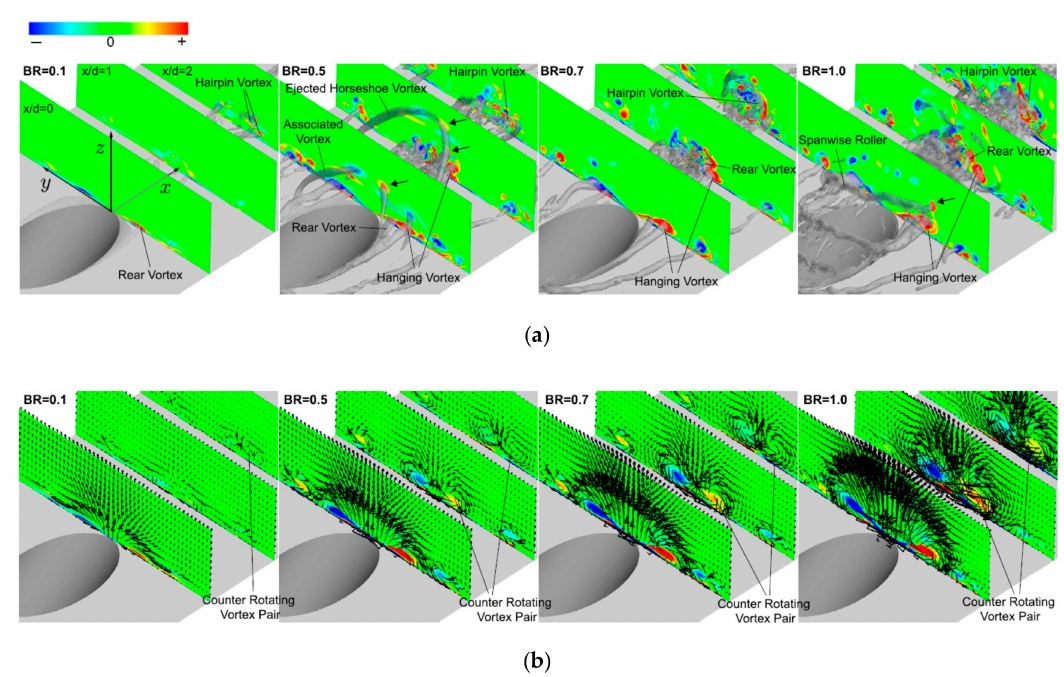
Figure 23. ( a ) Instantaneous and ( b ) time-averaged views of streamwise vorticity ( ω x ) for BR = 0.1, 0.5, 0.7, and 1.0